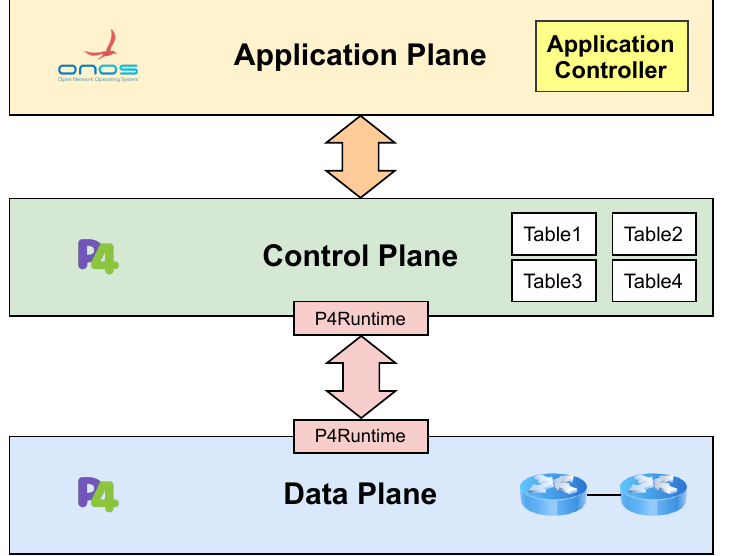
Figure 3. Three-tier SDN